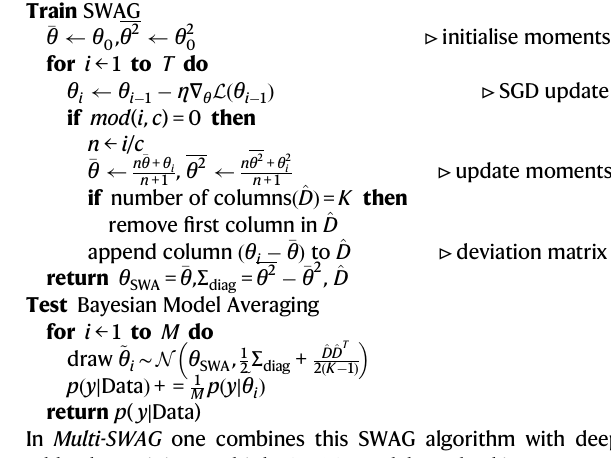
Fig. 9 | Architecture of the used Neural Network. For both regression and clas- si fi cation, the network fi rst consists of three stacked long short-term memory (LSTM) layers 98 of sizes 128, 128 and 64. For regression, the last LSTM is directly fully connected into the output layer returning a mean μ and variance σ , while for classi fi cation the output layer is preceded by another fully connected layer of size 20. The architecture is inspired by the successful applications of recurrent neural networks during the AnDi-Challenge 62,68,71,74